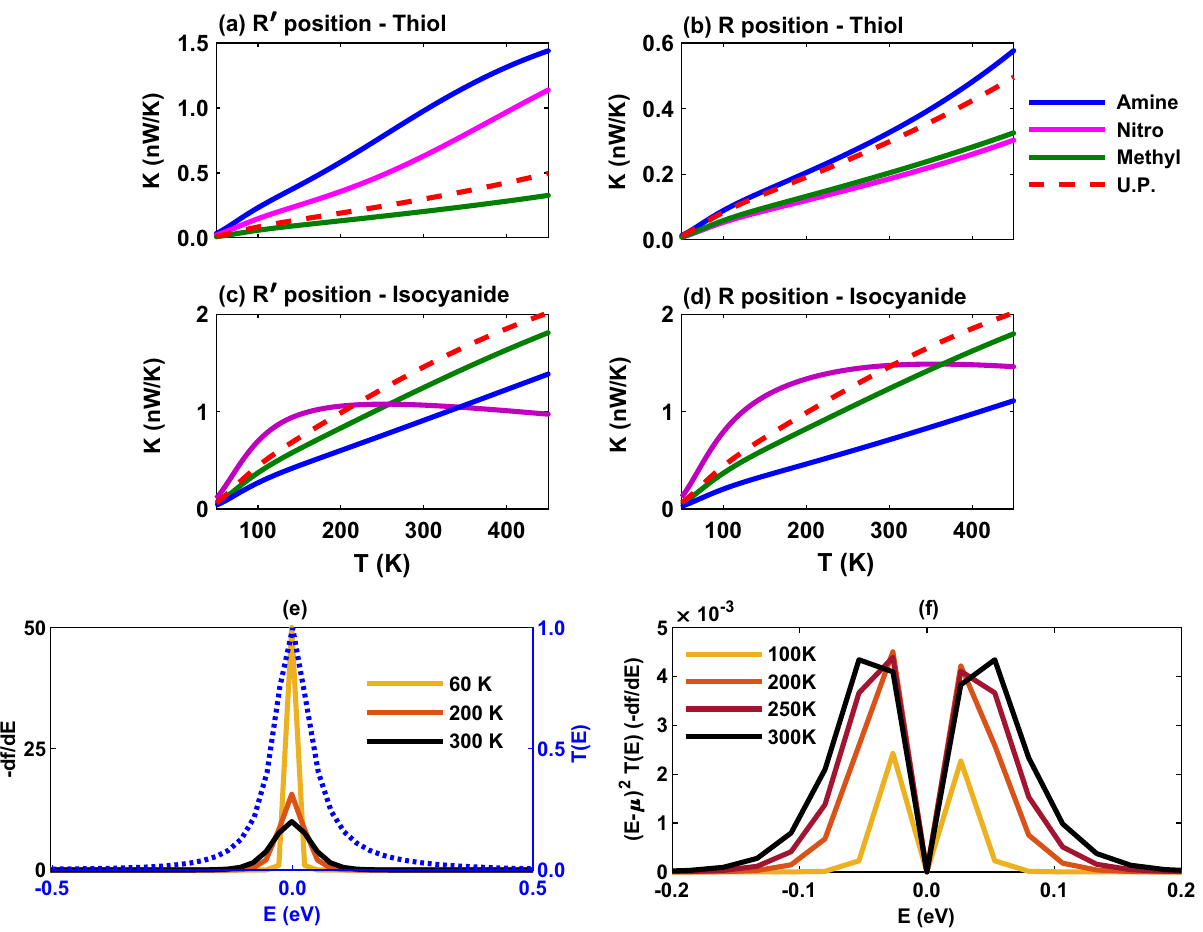
Figure 8. The thermal conductance of the Au-anthracene-Au junction as a function of temperature for the thiol-terminated junction in the presence of amine (blue), nitro (magenta) or methyl (green) as the side group in ( a ) R ′ and ( b ) R positions. The electrical conductance of the isocyanide-terminated junction with amine (blue), nitro (magenta) or methyl (green) side group in ( c ) R ′ and ( d ) R positions. Also, the thermal conductance of the unperturbed (U.P.; red) system in the absence of side groups is drawn as a reference. ( e ) Examplar representation of the Fermi derivative peak ( − df / d ε in the left axis; T = 60, 200, 300K ) and transmission coefficient peak ( T (ε) in the right axis; blue dotted curve) for the molecule anchored with the isocyanide anchoring group with nitro side group in the R ′ position. ( f ) (ε − µ) 2 T (ε)( − df / d ε) is drawn for the isocyanide-terminated junction with nitro side group in the R ′